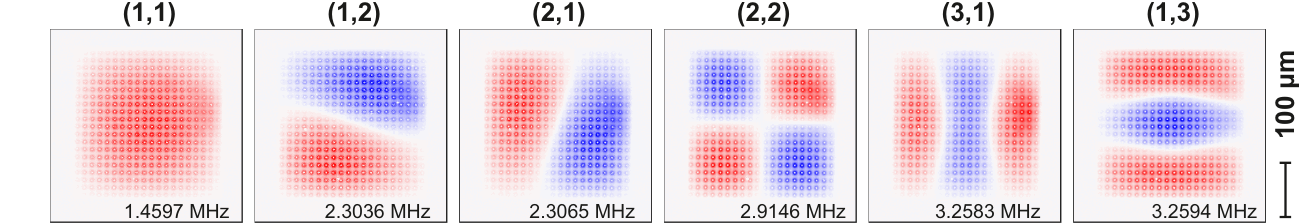
Figure 3. Normalized mode maps (real part) of the first six modes of the square SiN membrane acquired in a single, simultaneous, measurement with our PLL method. The release holes are visible as an array of dots across the entire surface of the structure. Starting frequencies are indicated in each map; further properties are listed in Table